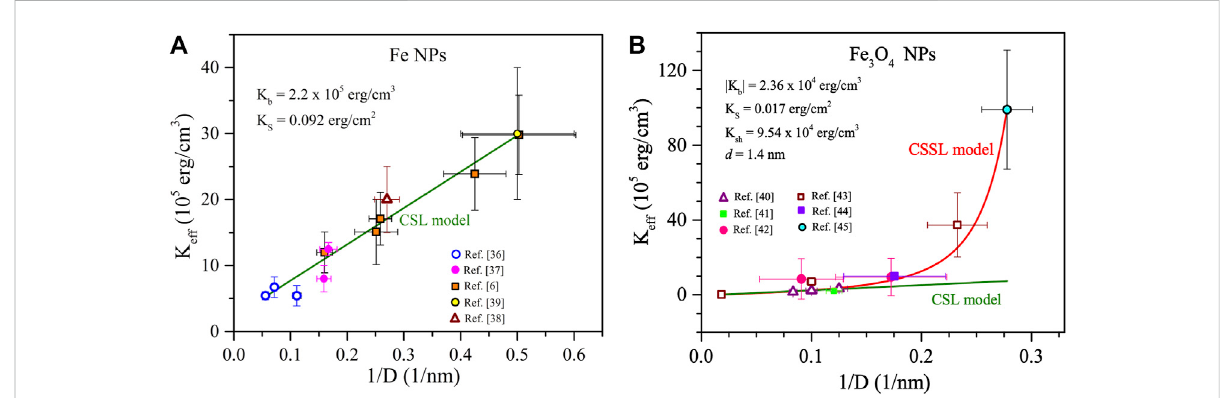
FIGURE 3 TheK eff vs.1/Dvariation of (A) Fe,and (B) magnetite(Fe 3 O 4 )NPs.Thered(green)lineshowsthebest fi tofthedatatotheCSSL(CSL)model.The best fi ttingparametersalongwiththesourcesofthedata(Mørupetal.,1982;Bødkeretal.,1992;Bodkeretal.,1994;BødkerandMørup,1994;Kumar et al., 2001; Goya et al., 2003b; Lima et al., 2006; Guardia et al., 2007; Wu et al., 2007; Dutta et al., 2009; Chesnel et al., 2014) are given in the inset.